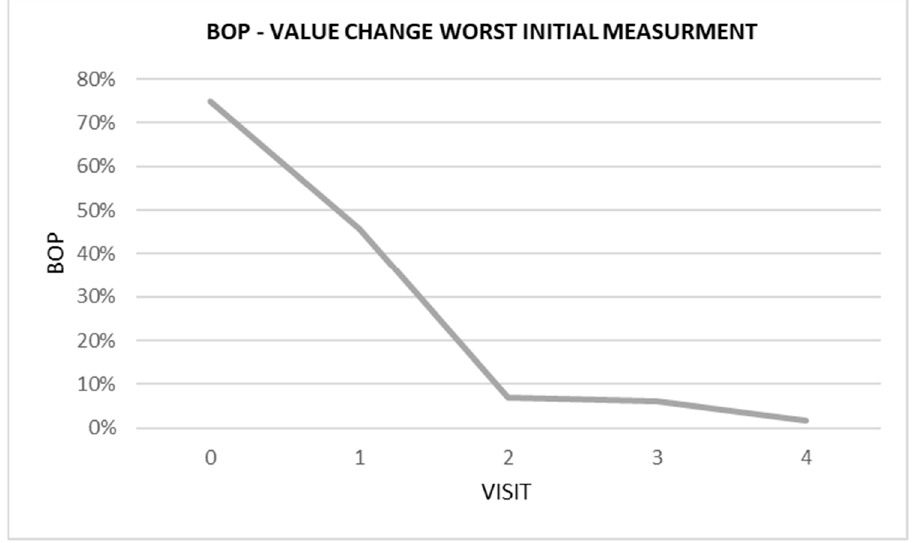
Figure 3. Graphical analysis of BOP decline in comparison to visit 0.